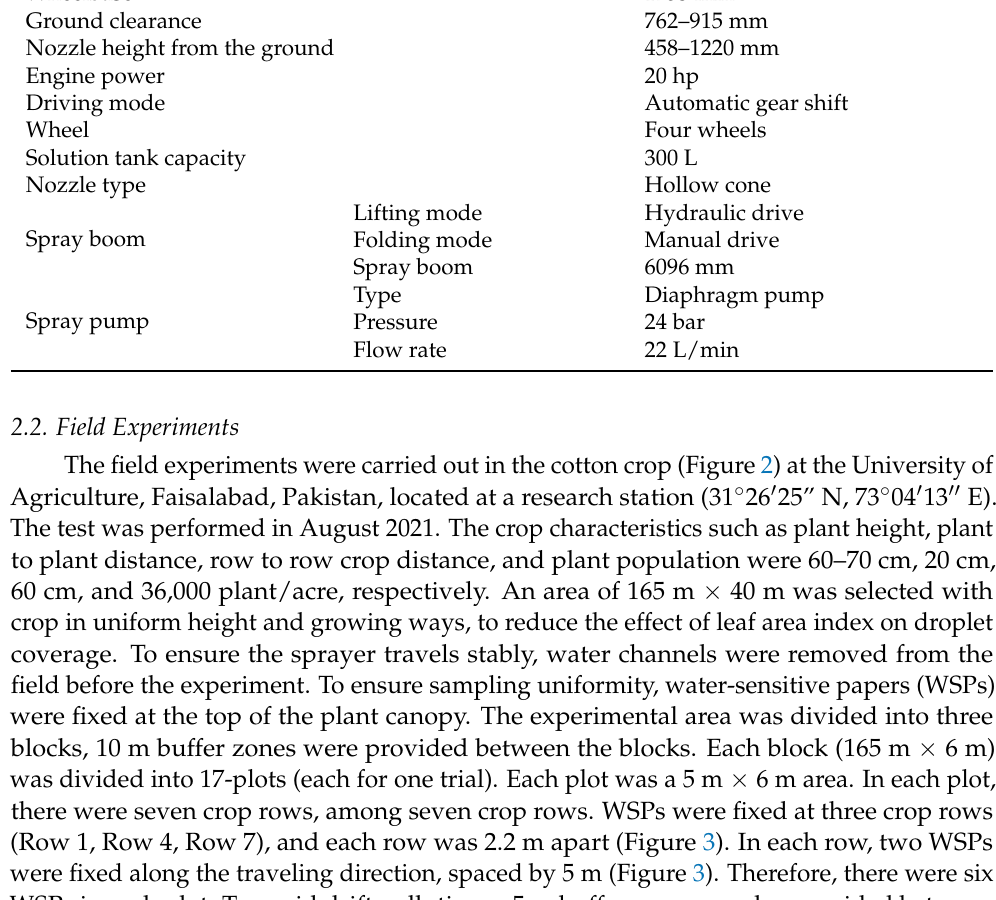
Table 1. Spraying vehicle specifications.